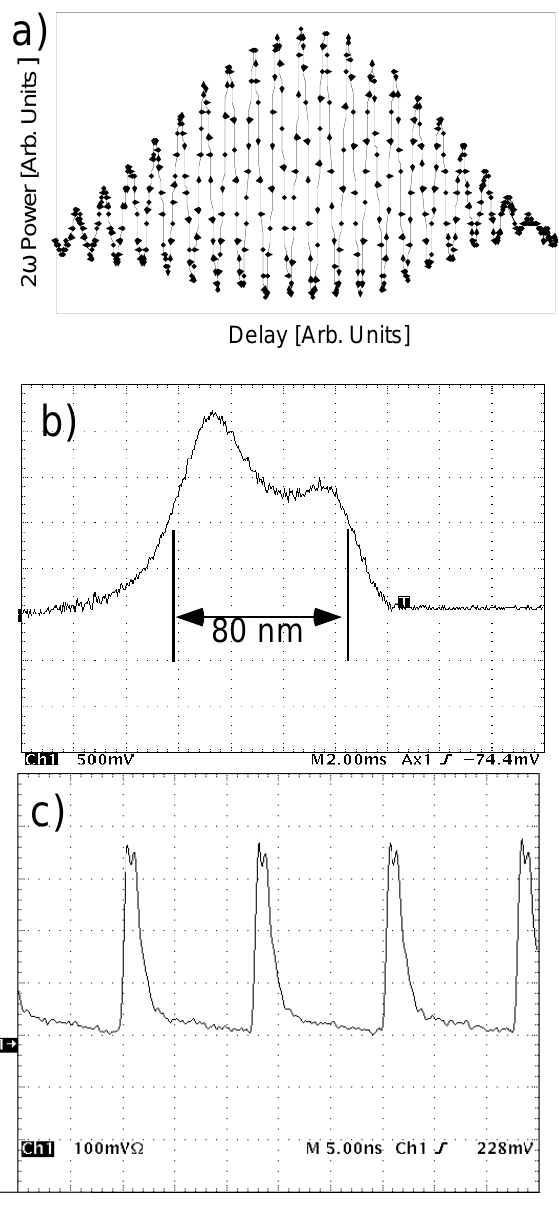
FIG. 7. (a) Autocorrelation trace, (b) spectrum, and (c) output pulse train as measured on photodiode of the Ti:Al 2 O 3 oscillator ( 5 ns (cid:1) div).